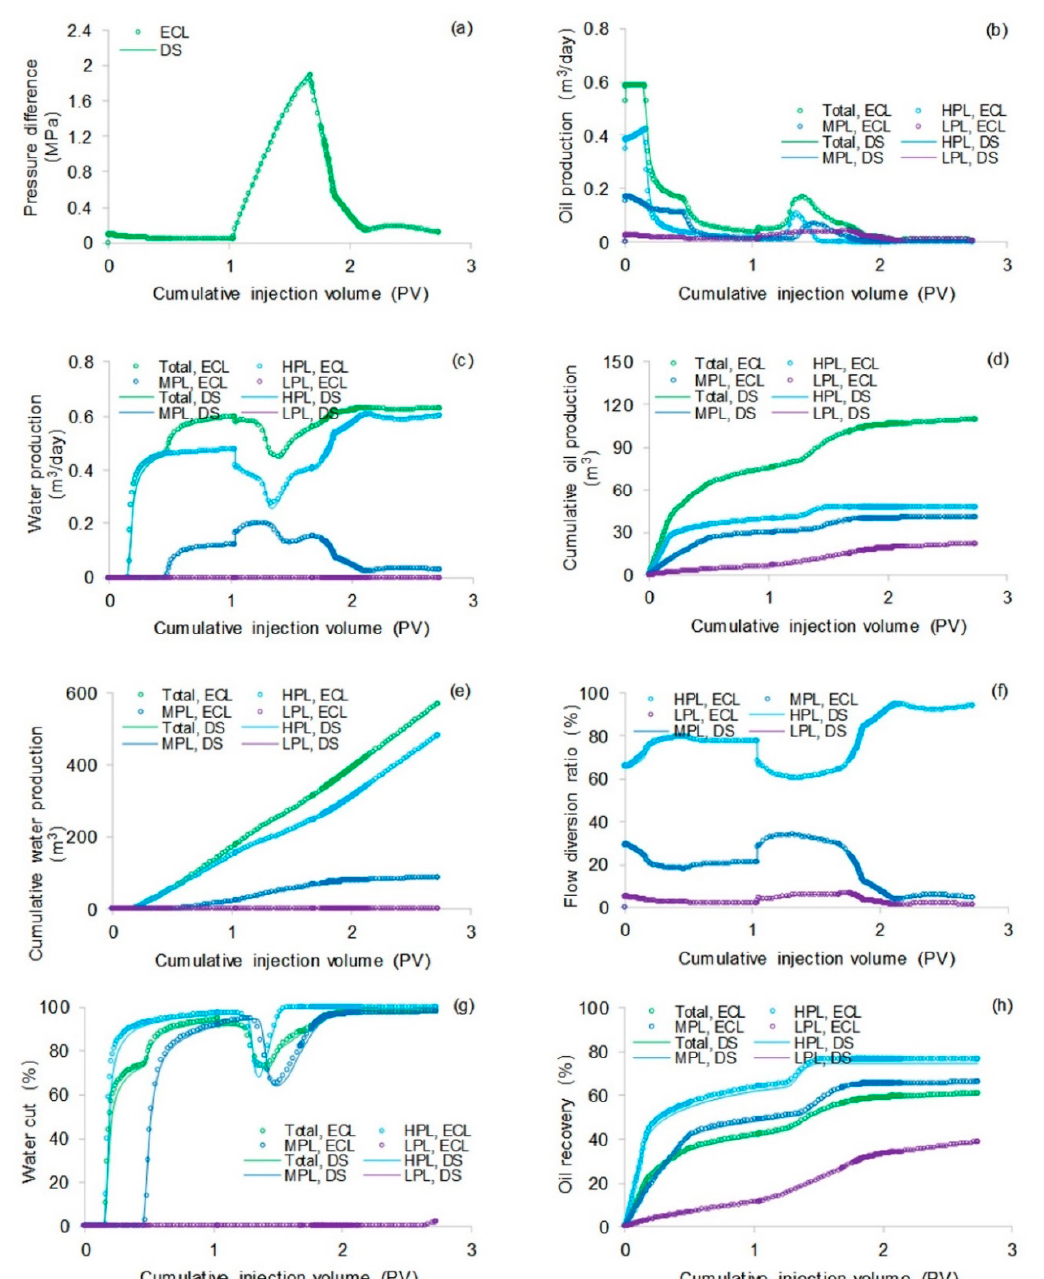
Figure 9. Comparisons of results in terms of: ( a ) pressure difference, ( b ) oil production, ( c ) water production, ( d ) cumulative oil production, ( e ) cumulative water production, ( f ) flow diversion ratio, ( g ) water cut, and ( h ) oil recovery using ECLIPSE V2013.1 software and designed simulator for the situation without polymer degradation.